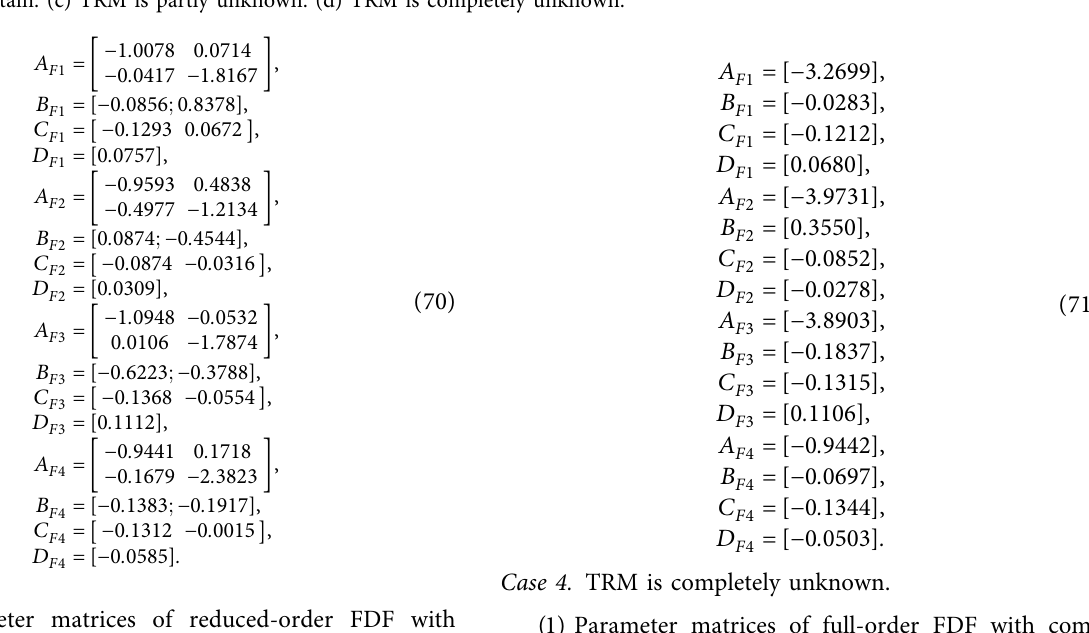
Figure 2: Residual generation of full-order FDF for four different TRMs cases. (a) Case 1. TRM is completely known. (b) Case 1. TRM is polytopic uncertain. (c) TRM is partly unknown. (d) TRM is completely